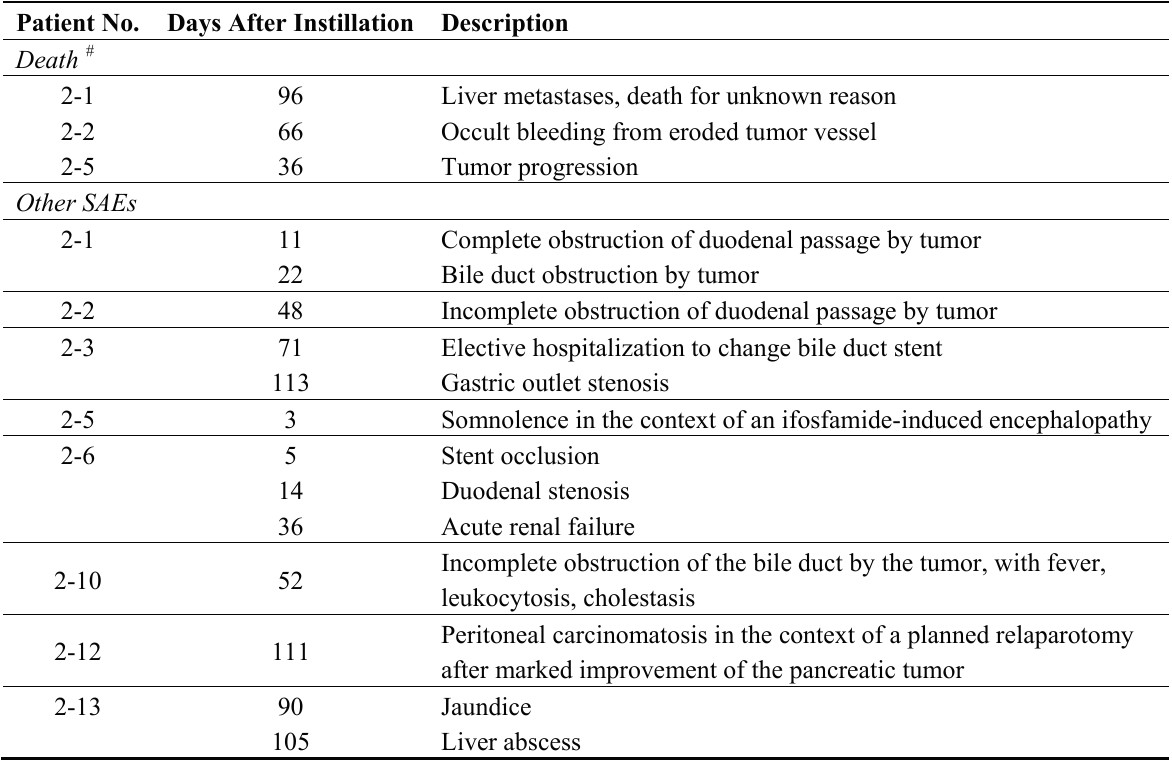
Table 3. Documented deaths and serious adverse events (SAEs) in the phase 2 trial. Patient